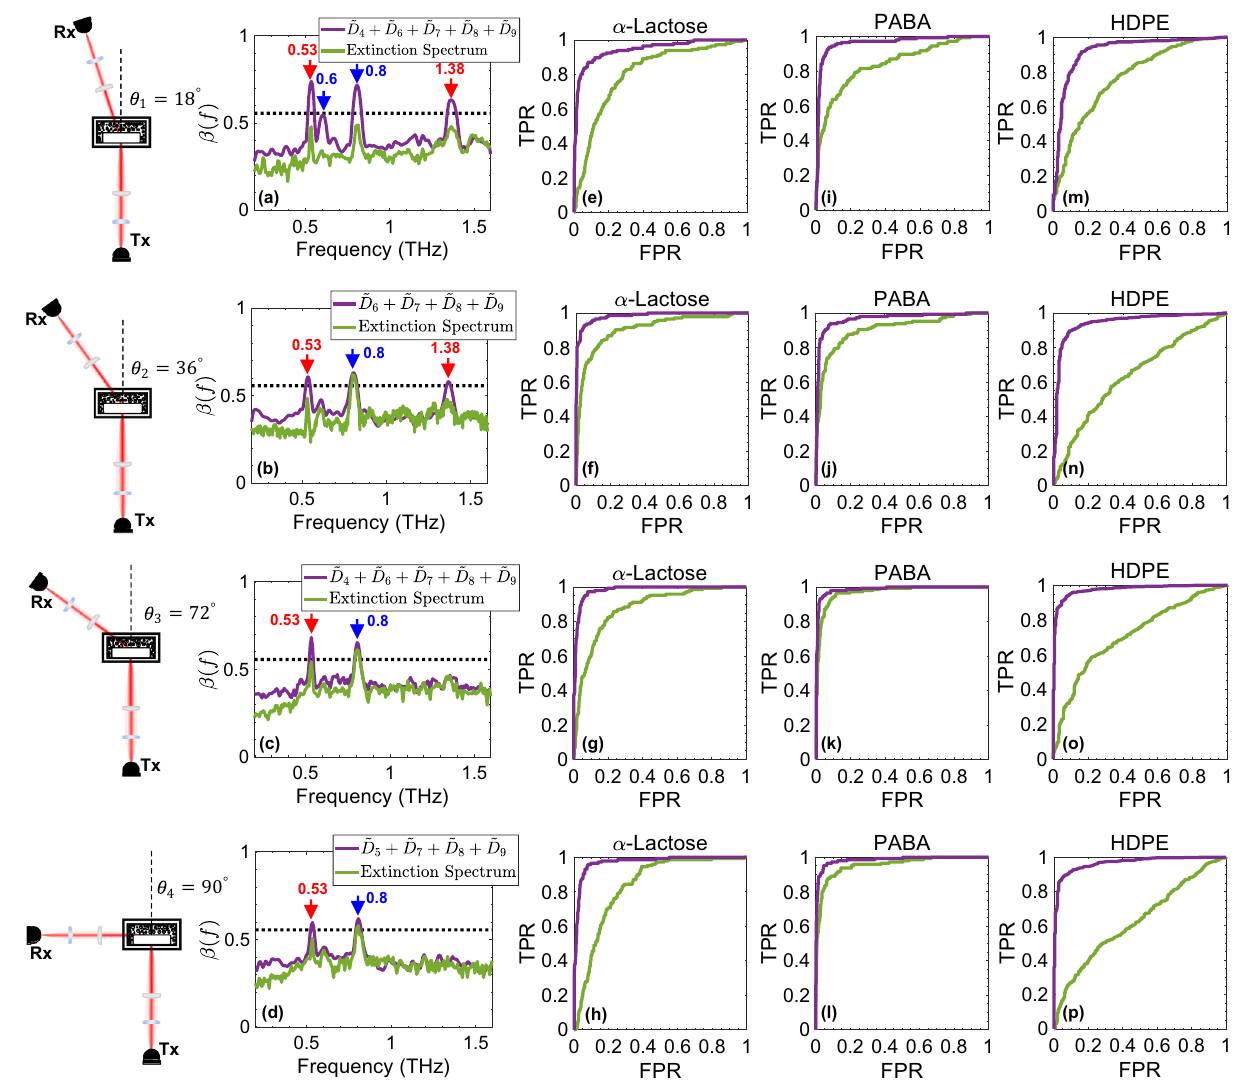
Figure 4. Diffuse THz spectroscopy, ( a - d ) the bimodality spectra obtained using the diffuse extinction spectra and their MODWT detail vectors at the oblique detection angles including θ 1 = 18 ◦ , θ 2 = 36 ◦ , θ 3 = 72 ◦ , and θ 4 = 90 ◦ , ( e - h ) the ROC curves obtained for the identification of the region of α -lactose using the diffuse extinction spectra and their MODWT detail vectors at each oblique detection angle, ( i - l ) similar to ( e - h ) for the identification of the region of PABA, ( m - p ) similar to ( e - h ) for the identification of the region of